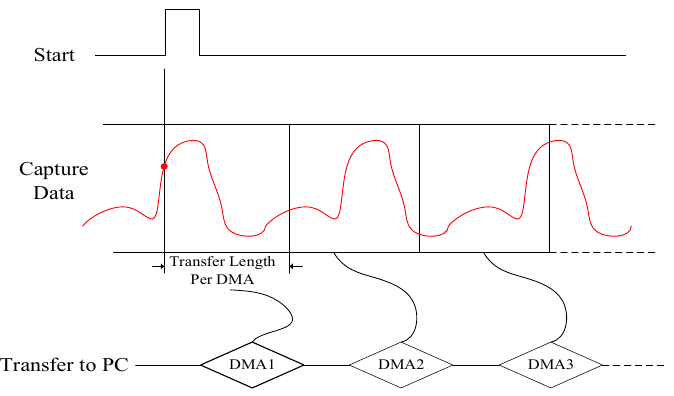
Figure 7. The schematic diagram of data acquisition and transmission.